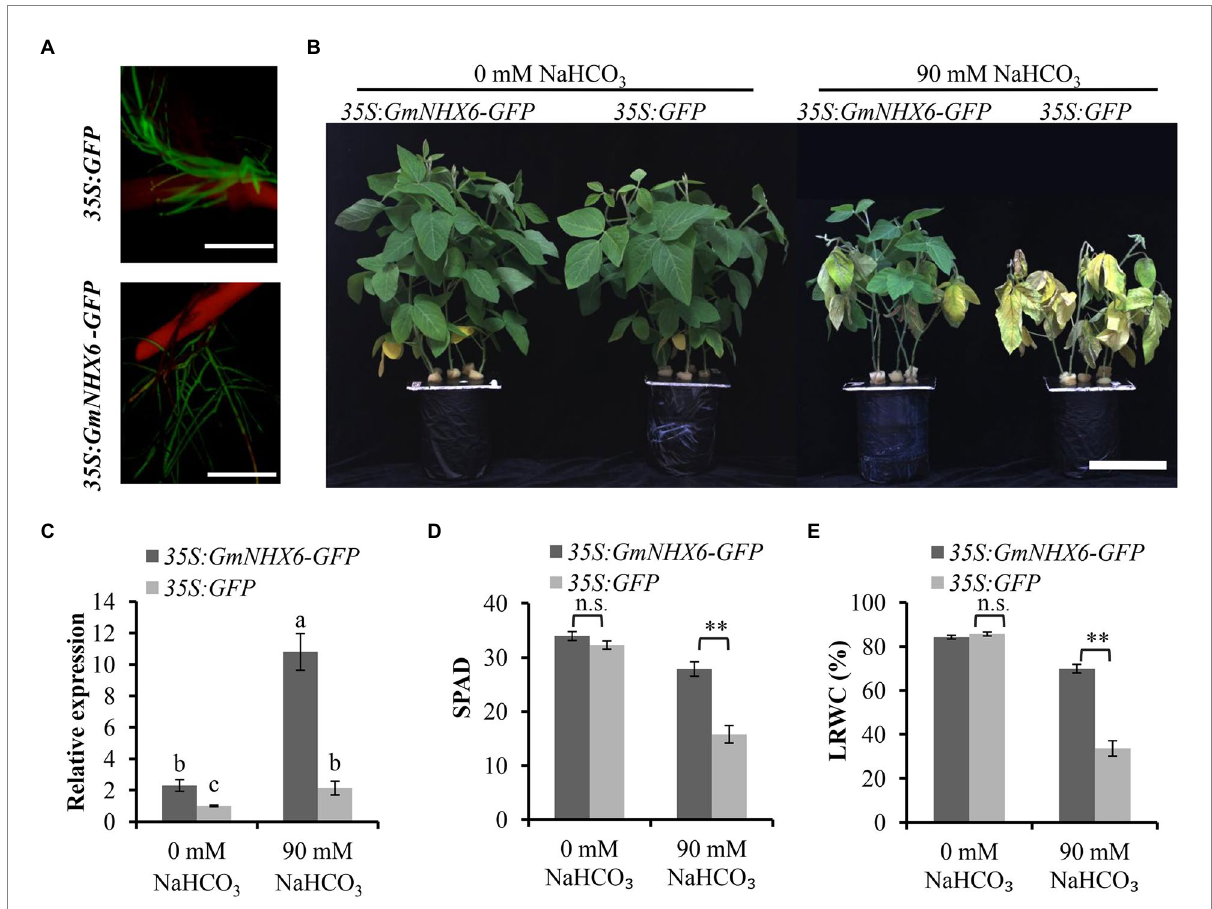
FIGURE 3 Alkaline salt tolerance analyses of transgenic soybean composite plants. (A) Identification of positive transgenic soybean lines by green fluorescence using a stereoscopic fluorescence microscope. Bar = 1 cm. (B) Representative phenotype of transgenic soybean composite plants (25-day-old) under 0 mM or 90 mM NaHCO 3 for 7 days. Bar = 12 cm. (C) Relative expression of GmNHX6 gene in the roots of soybean composite plants at 24 h after 0 or 90 mM NaHCO 3 treatment by qRT-PCR. For relative expression calculation, the sample from soybean composite plants with empty vector (35S: GFP ) under 0 mM NaHCO 3 was used as control and GmUKN1 was the reference gene. Data represents the mean ± standard deviation of three biological replications with three repeats within each replication ( n = 3 × 3 = 9). Bars with the same letter in lowercase above bars indicate no significant difference according to Duncan’s multiple range test at 0.05 level. (D,E) The Soil and Plant Analysis Development (SPAD) value for chlorophyll content, and leaf relative water content (LRWC) of transgenic soybean composite plants under 0 mM or 90 mM NaHCO 3 for 7 days, respectively. Data represents the mean ± standard deviation of three biological replications and each repeat contained five independent transgenic plants for each genotype ( n = 3 × 5 = 15). Soybean variety of “TianLong1” was used. Differences were evaluated using the two-tailed Student’s t -tests (n.s., not significant; ** p <